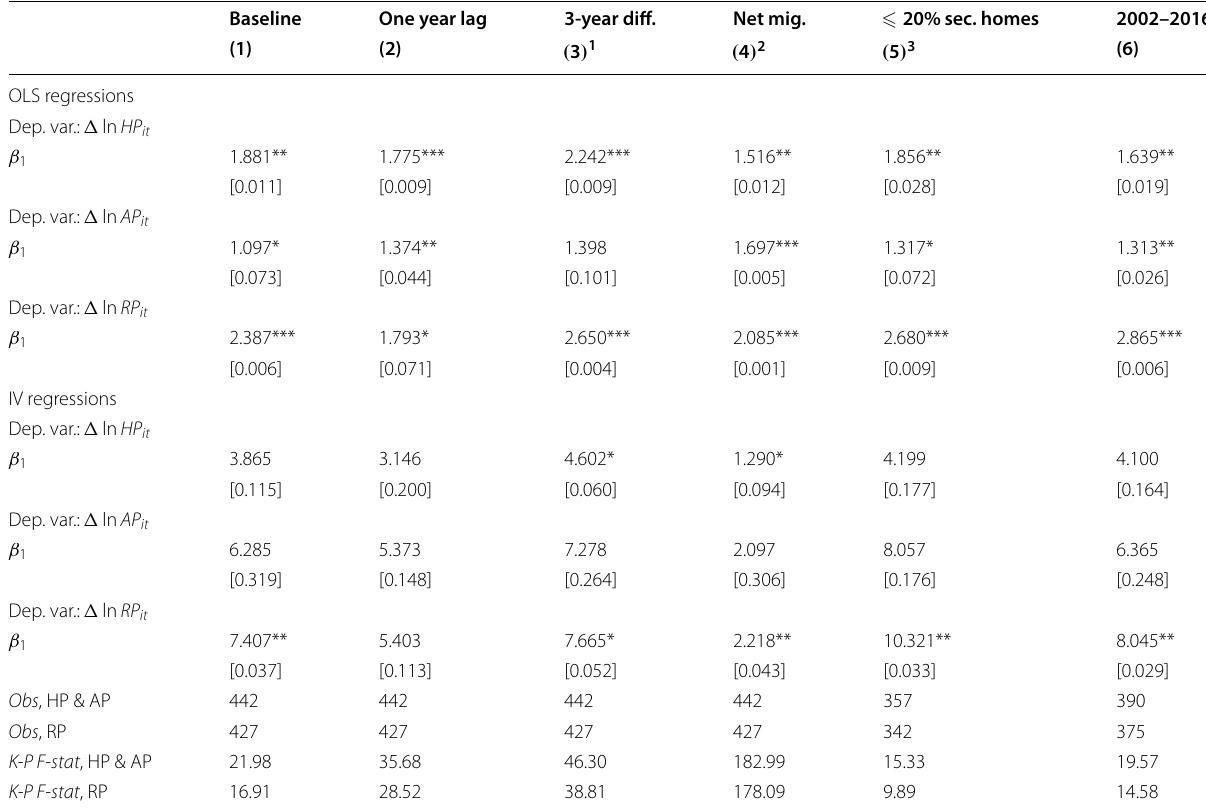
Table 10 Housing prices and immigration—cantons from 1998–2016: Sensitivity analysis. Source: Own calculations based on data from Wüest Partner and Federal Statistical